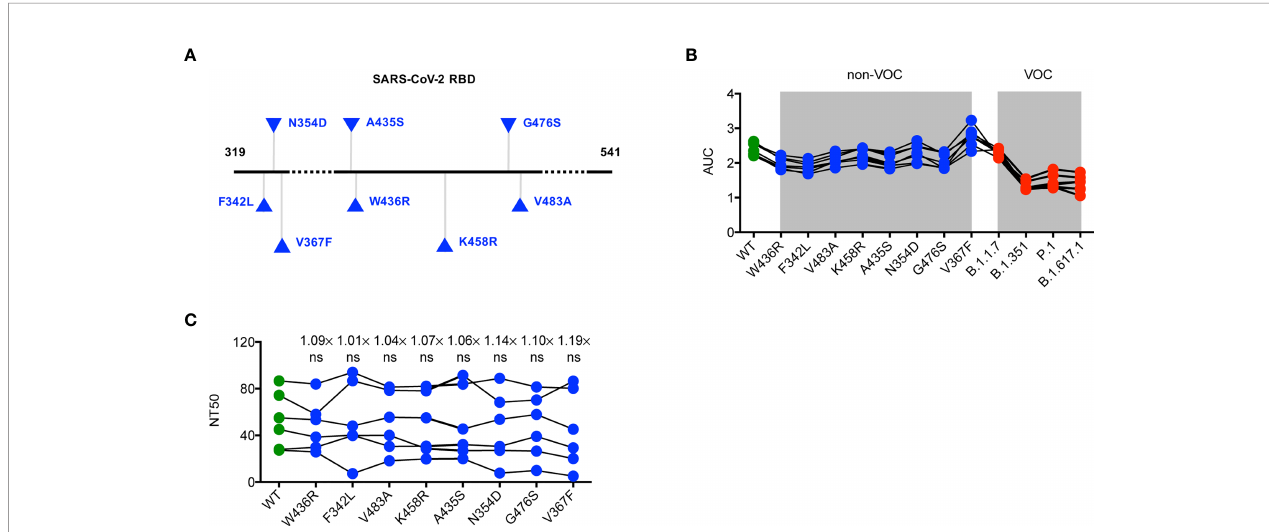
FIGURE 2 | Neutralization of SARS-CoV-2 non-VOC variants by convalescent sera. (A) Schematic diagram presenting the location of mutations of non-VOC variants in the context of RBD protein domain. (B) ELISA binding assay of sera originated from COVID-19 patients with severe illness to ELISA plate coating of RBD proteins of WT RBD and its mutated variants as indicated. (C) COVID-19 convalescent patient serum-mediated inhibition of indicated RBD proteins binding to ACE2 protein by ELISA. The data are representative of at least two independent experiments. Not signi fi cant,